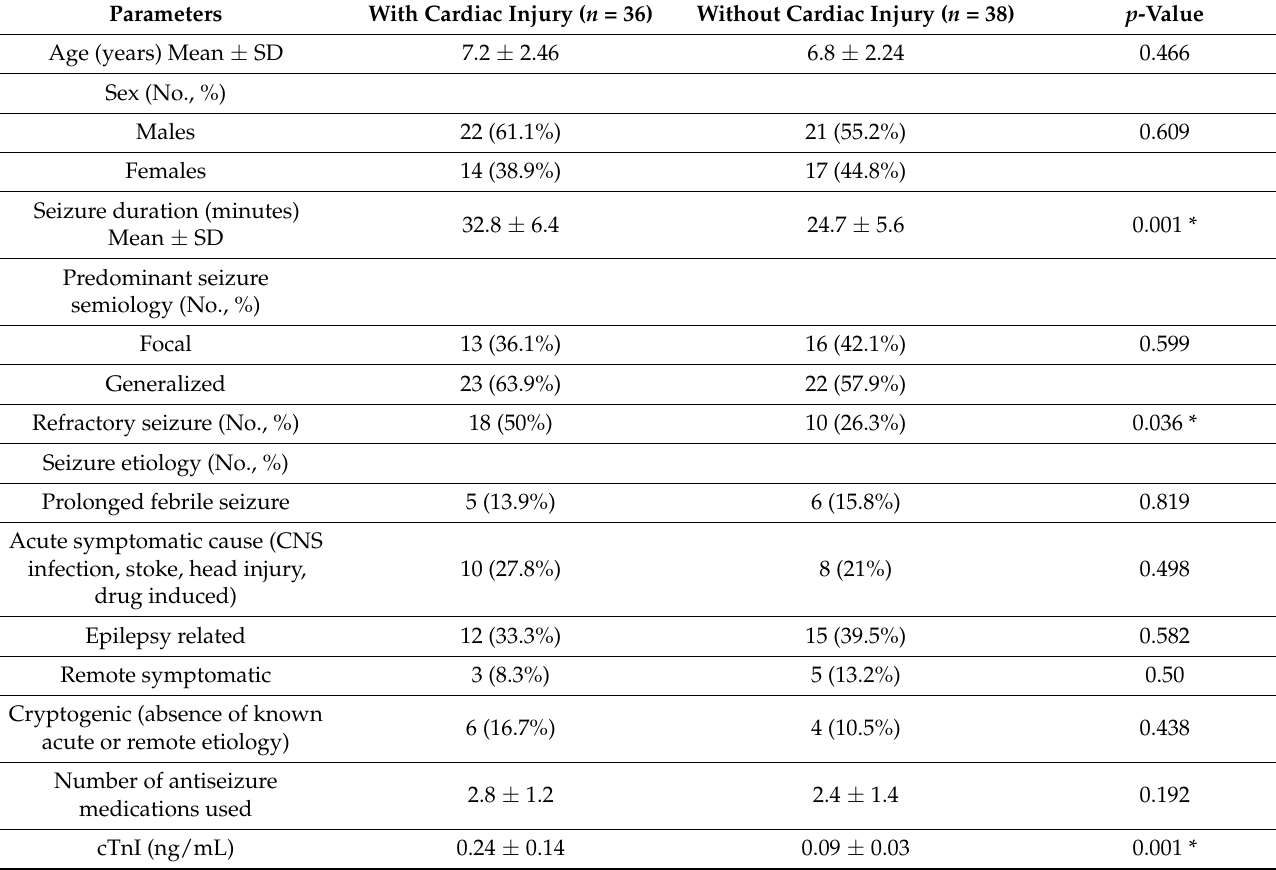
Table 1. Clinical and laboratory characteristics of patients with and without cardiac